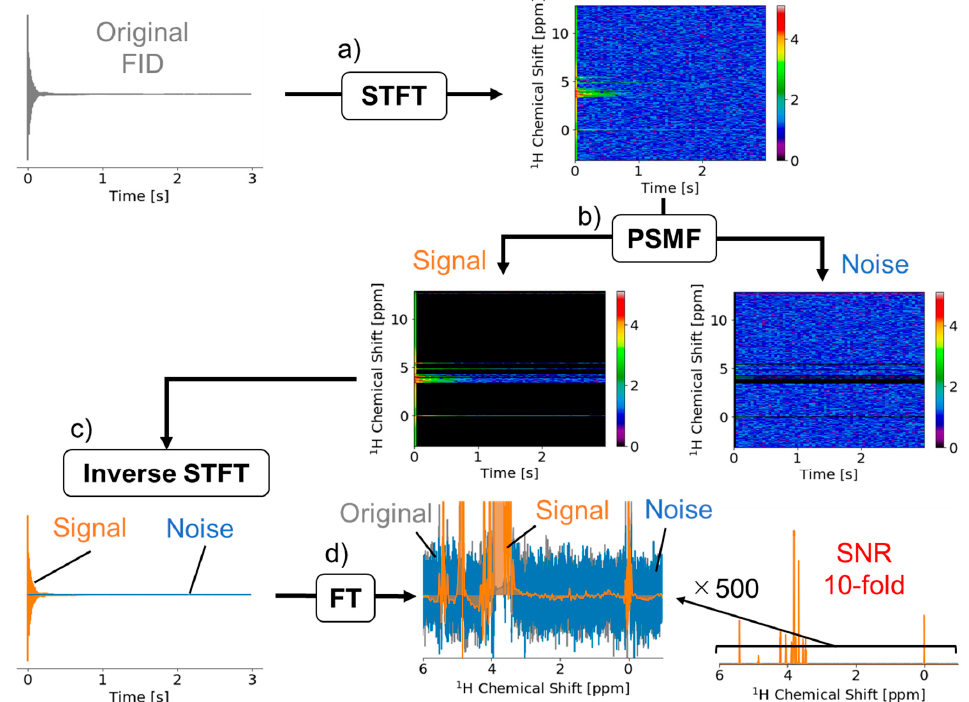
Figure 1. The free induction decay (FID) signal deconvolution method and its application to 1 H-NMR data for sucrose. ( a ) The spectrogram was obtained by applying short-time Fourier transform (STFT) to the original FID. ( b ) The matrix obtained after STFT was applied to probabilistic sparse matrix factorization (PSMF), which separated it into signal and noise components. ( c ) The signal and noise components were converted into a noise-removed FID signal (orange) and a time-domain noise signal (blue) by using inverse short-time Fourier transform. ( d ) Finally, the noise-removed FID and the time-domain noise signal were converted to a frequency-domain spectrum by applying standard Fourier transform. As compared with the original FID, the signal-to-noise ratio of the denoised FID was improved about tenfold.